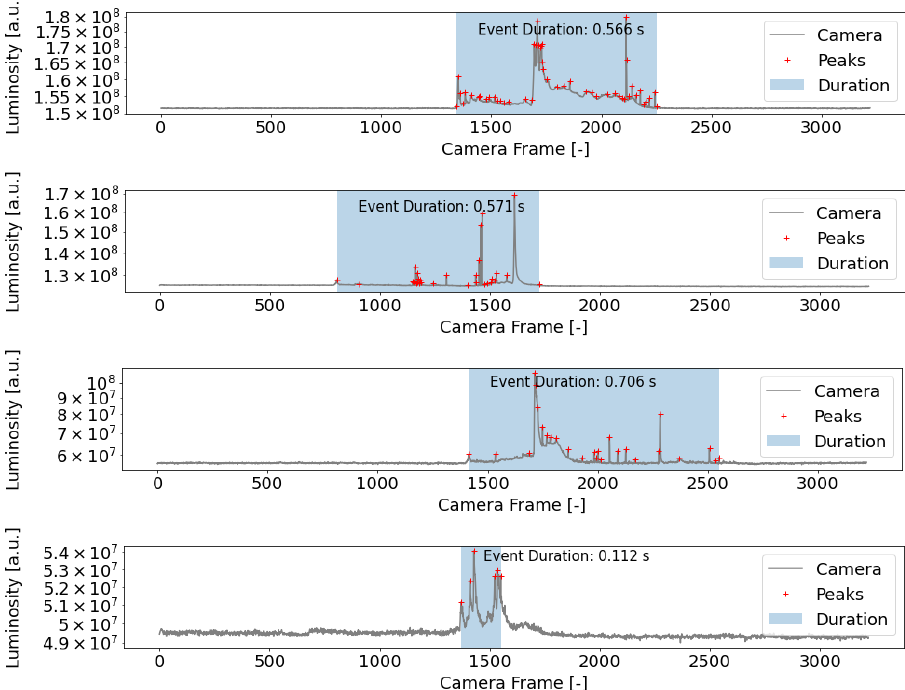
Figure 17. Examples of the detection of lightning event duration. Red crosses are detected peaks in signals generated by lightning processes. The determined length of the lightning duration is highlighted. The duration of the camera frame is 620µs.